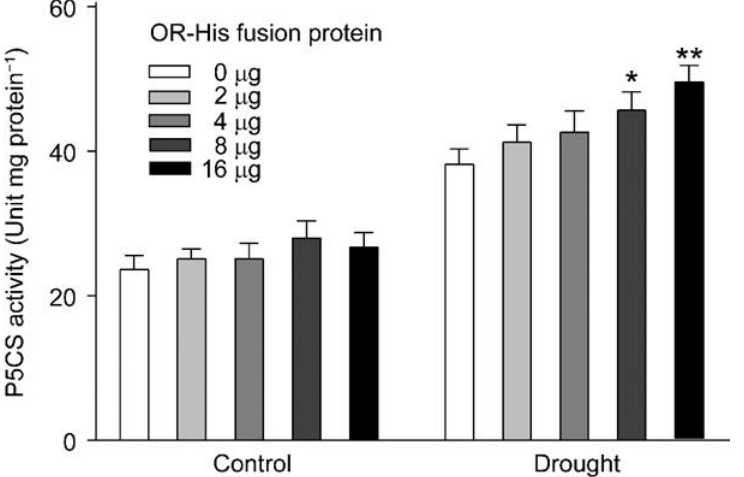
Figure 7. OR improves the enzymatic activity of P5CS. Total protein extract was prepared from the wild-type seedlings under normal growth conditions (control) or drought treatment. Different amounts of heterologously expressed and purified OR protein, with a His-tag (OR-His), was supplemented to the extract for P5CS enzymatic assay. Data are means ± SEM ( n = 3, * p < 0.05, ** p < 0.01, or better, Student’s t test).